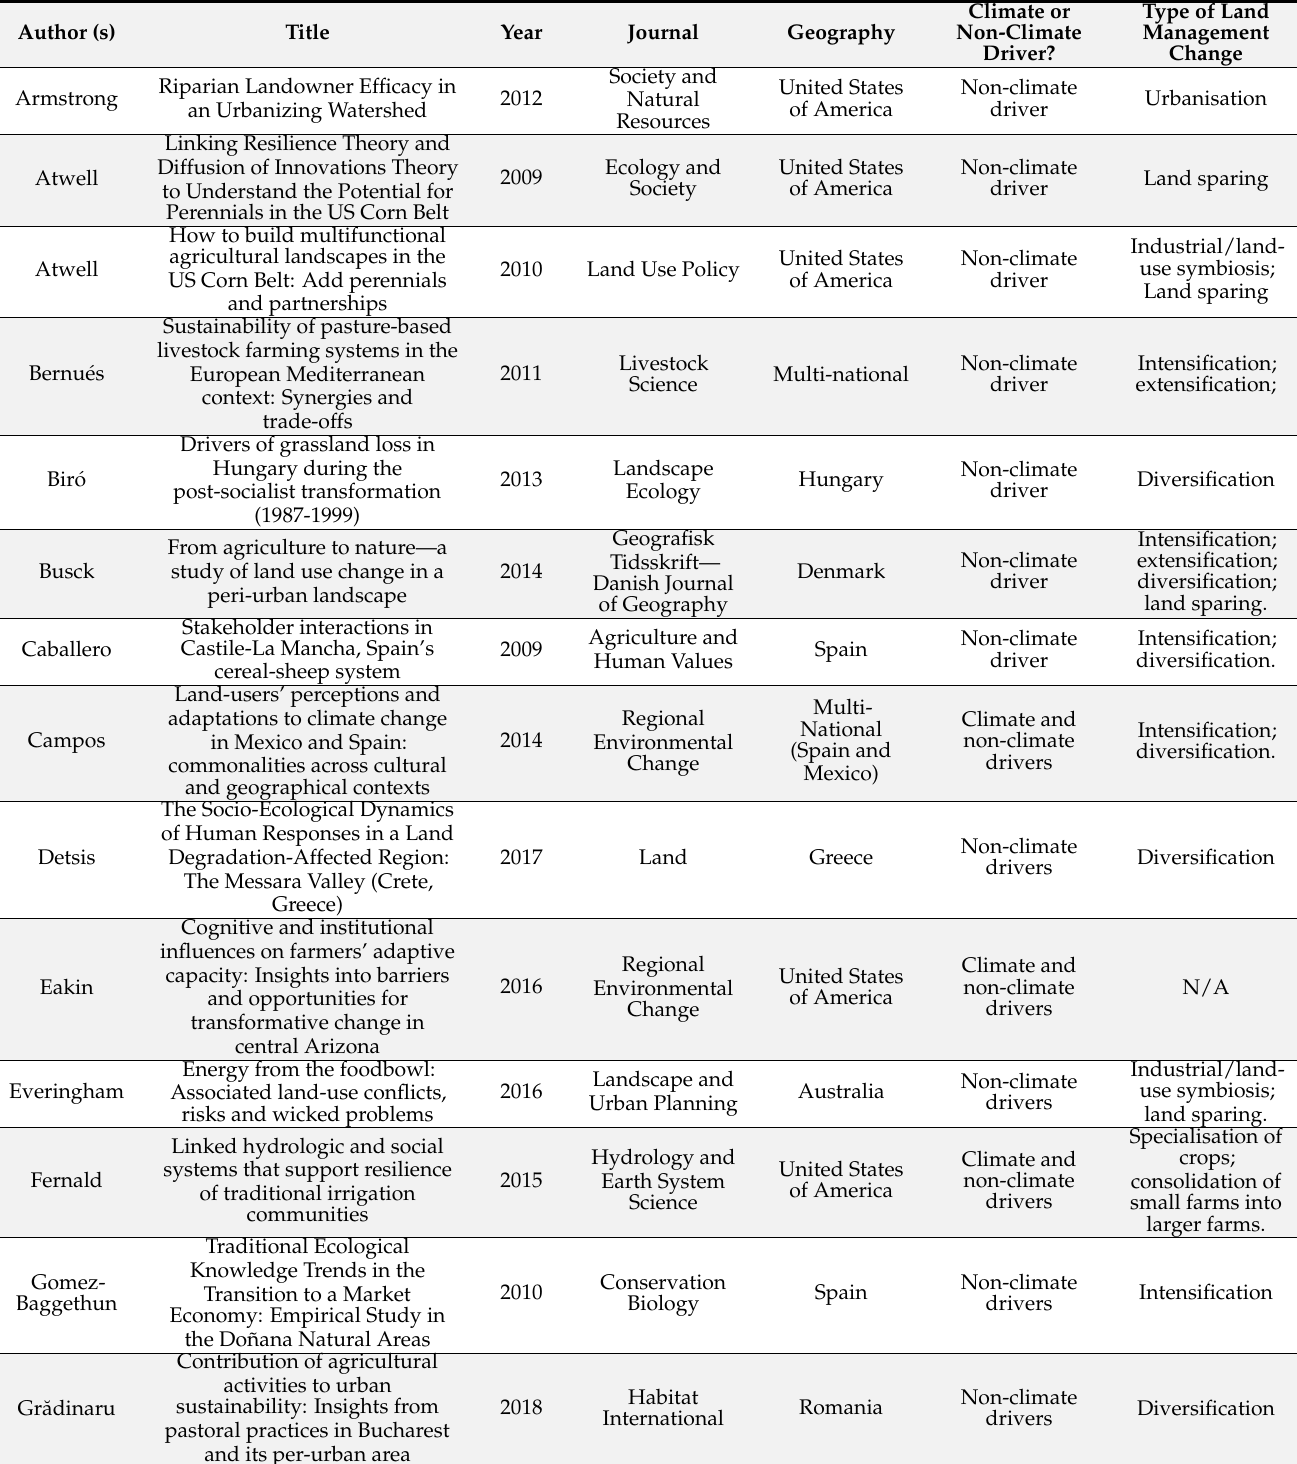
Table A1. Details of the 31 Papers That Were Included as Part of This